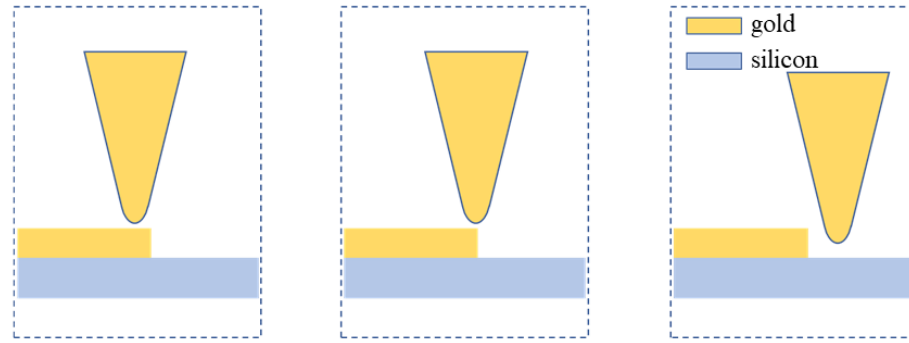
Figure 7. Three typical positions of tip corresponding to edge effect in s-SNOM.